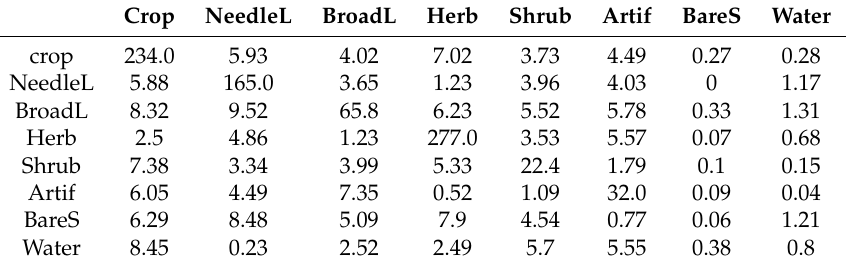
Table A4. Confusion matrix with random errors and medium overall accuracy. Crop